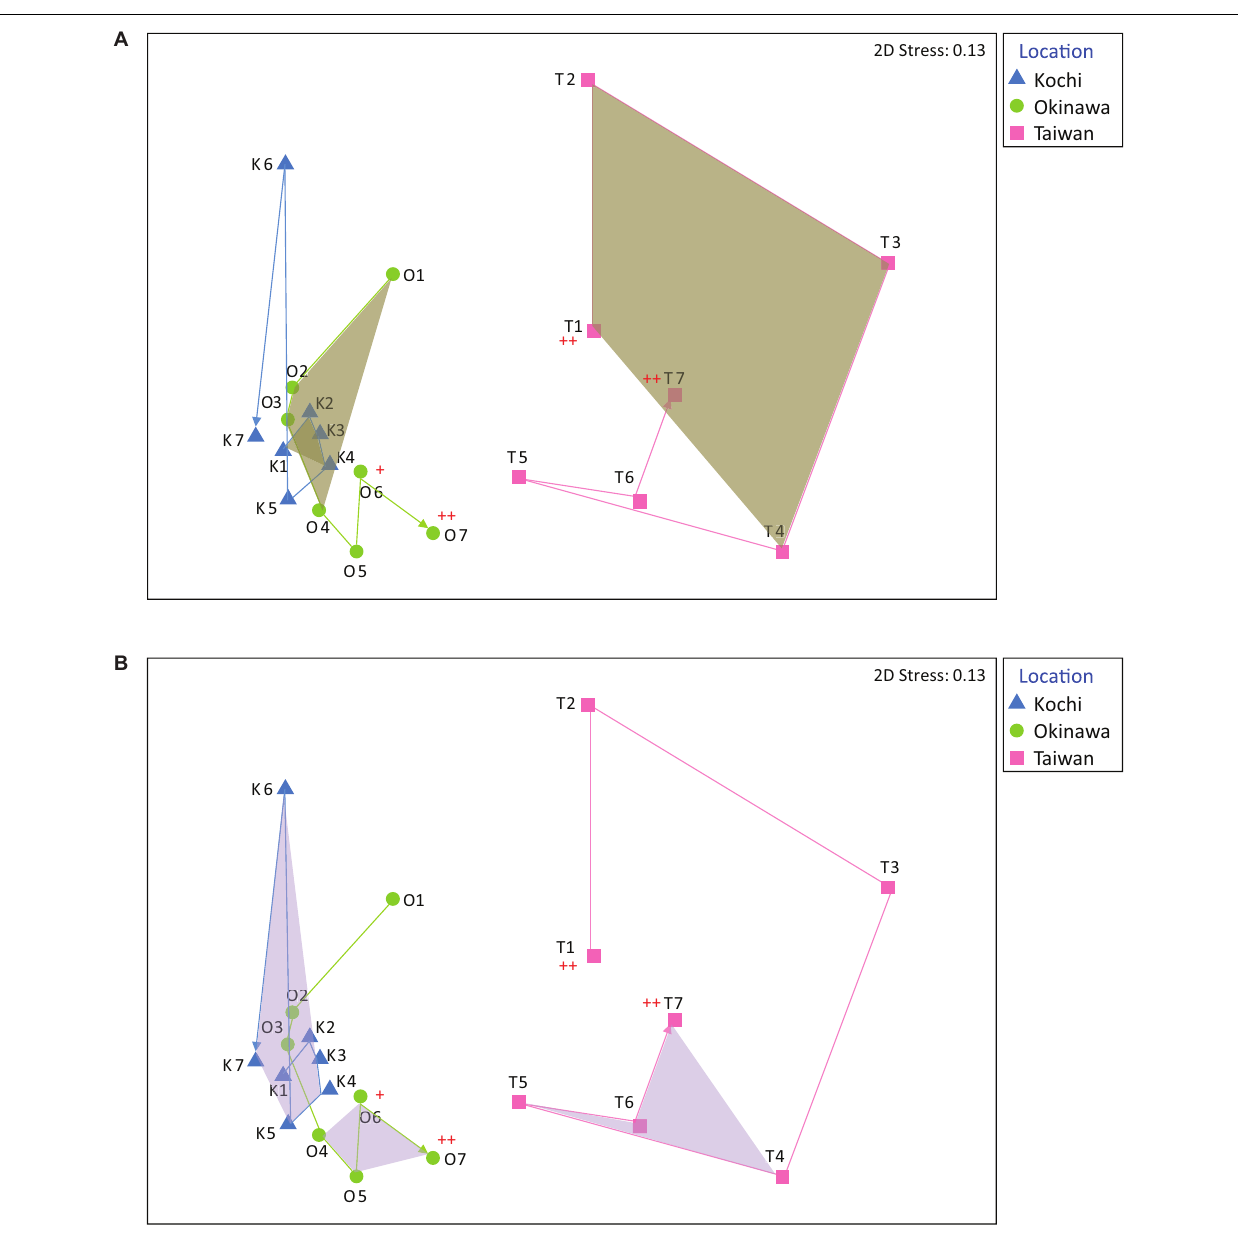
FIGURE 2 | Non-metric multidimensional scaling (nMDS) analysis of bacterial genera in Acropora muricata from Kochi, Okinawa, and Taiwan during (A) autumn and winter (samples K1-K4, O1-O4, and T1-T4) and during (B) spring and summer (samples K4-K7, O4-O7, and T4-T7). A cross indicates sampling after typhoon about 1 month and two crosses indicate sampling just after the